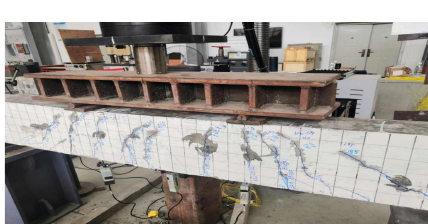
Figure 6: Over-stretch failure of the